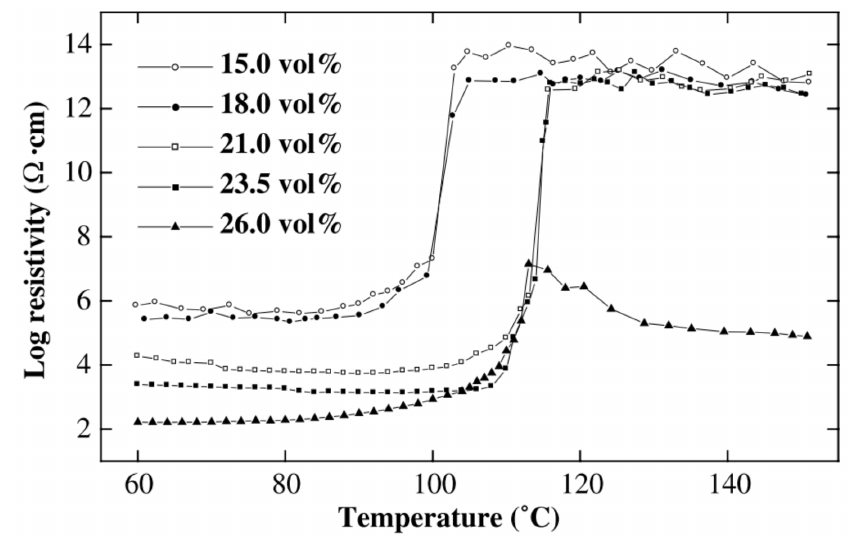
Figure 3. Log resistivity against temperature of low-molecular weight polyethylene (LMWPE)/ultra- high molecular weight polyethylene (UHMWPE) composites filled with different carbon fiber volume contents [21]. Reproduced with